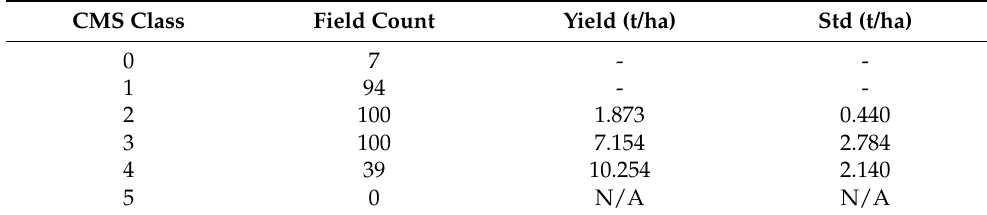
Table 4. Yield estimation for maize in the 2022 growing season.